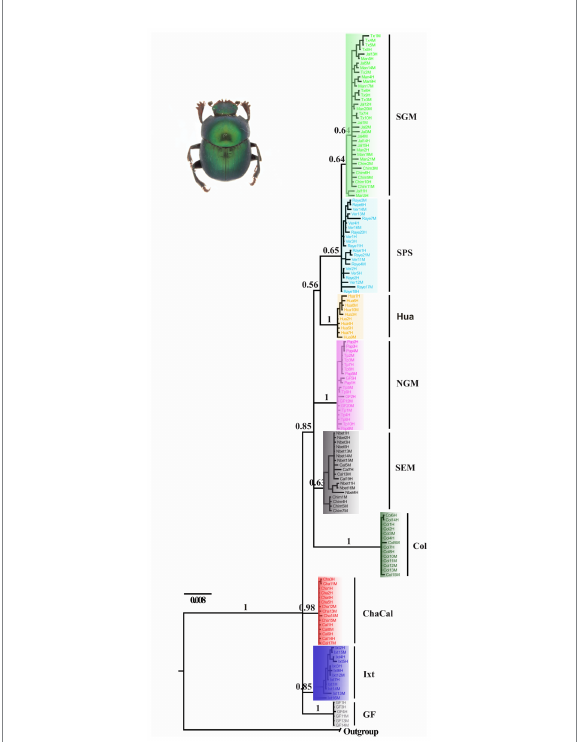
FIGURE 3 Bayesian consensus tree obtained by Nolasco-Soto et al. (2020) inferred from a multilocus dataset (ITS2 + 16S + COI). SGM, Jalcomulco, Los Tuxtlas, La Mancha, Los Chimalapas; SPS, El Vergel and Raymundo Enríquez; Hua, Huatulco; NGM, Papantla, Tuxpan and Gómez-Farías; SEM, Nueva Betania, Calakmul and Los Chimalapas; Col, Colombia; ChaCal, Chamela and Calakmul; Ixt, Ixtapa; GF, Gómez